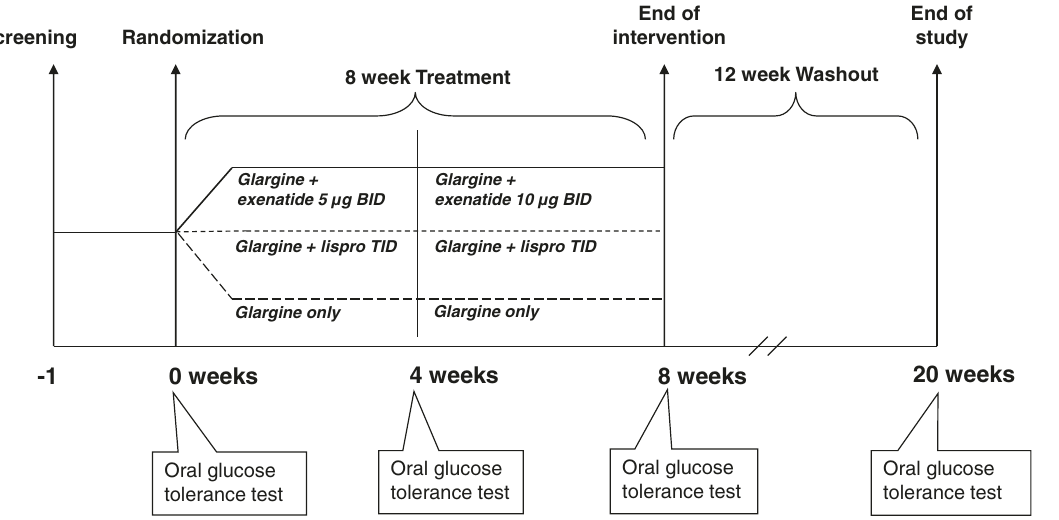
Fig. 1 | Flow diagram showing study